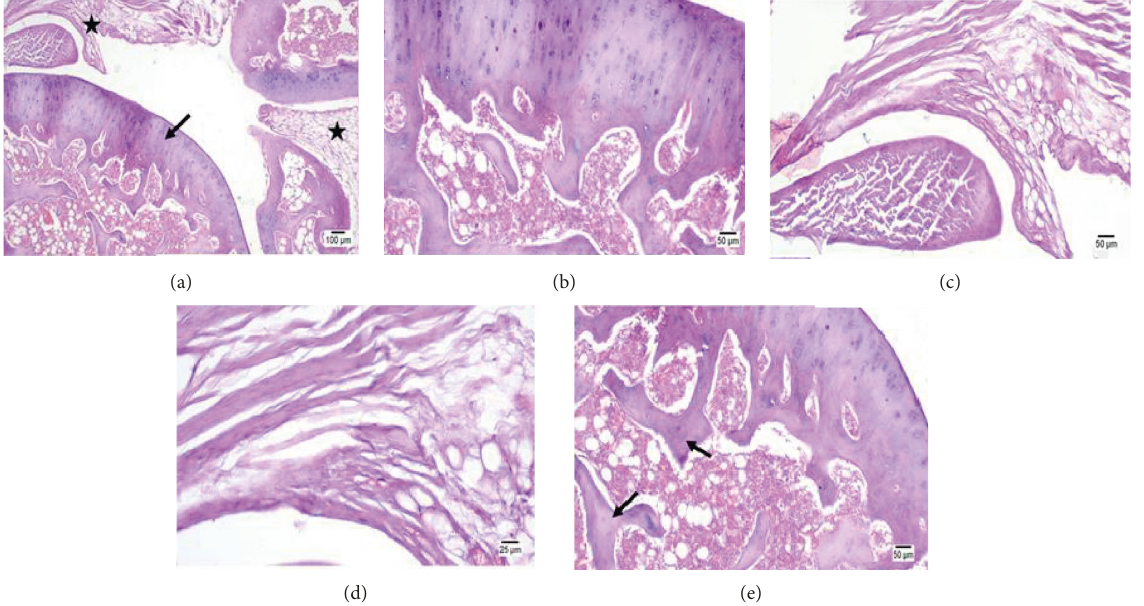
Figure 9: Group (300 ppm): (a) normal articular cartilage (arrow) and synovium (star), (b) higher magnification and normal articular cartilage, (c) higher magnification and normal synovium and joint capsule, (d) higher magnification and normal joint capsule, and (e) normal trabecular bone (arrow).